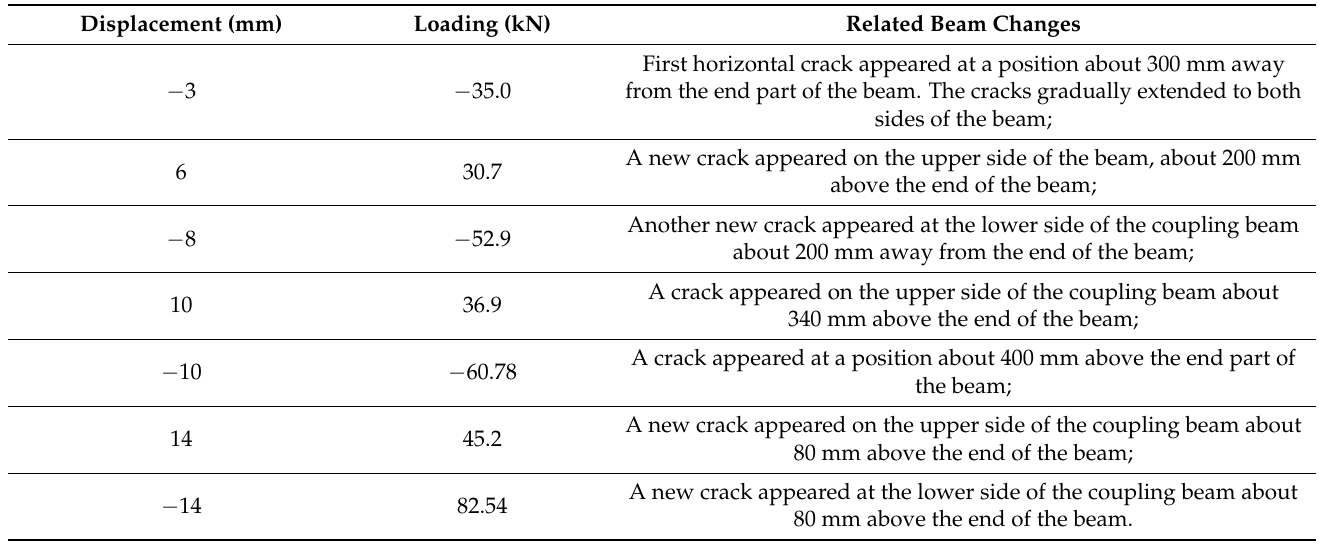
Figure 13. Quasi-static loading scheme. Table 4. Critical test